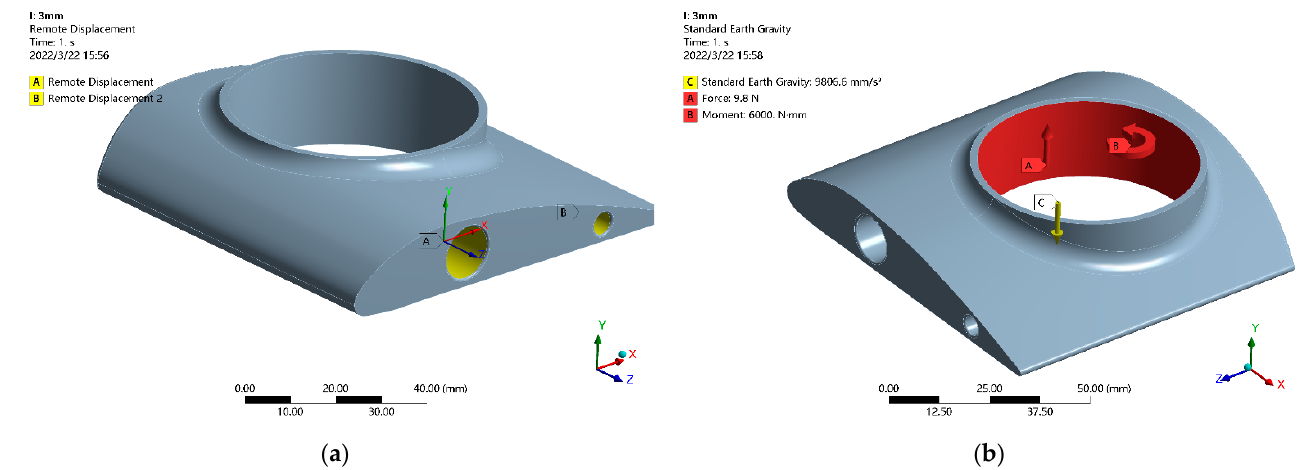
Figure 5. Boundary conditions of the model. ( a ) Freedom constraint; ( b ) force setting.